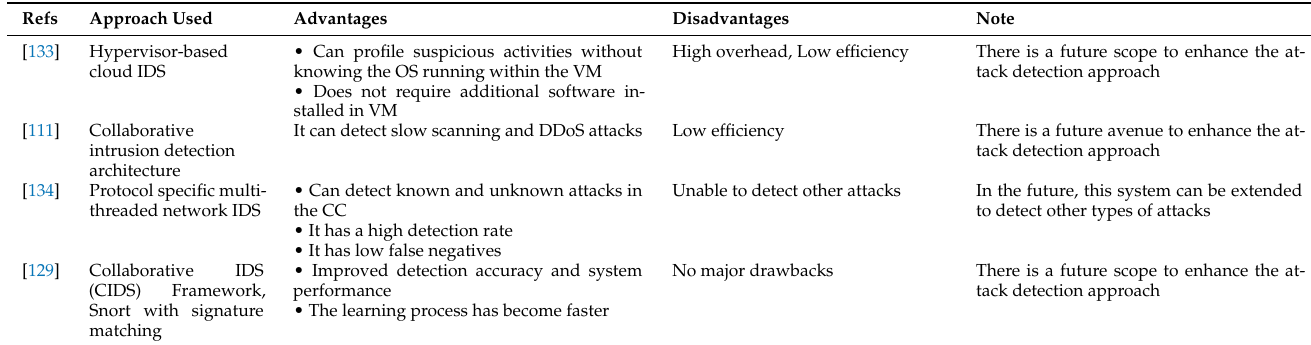
Table 13. Advantages and disadvantages of hybrid-based DDoS detection